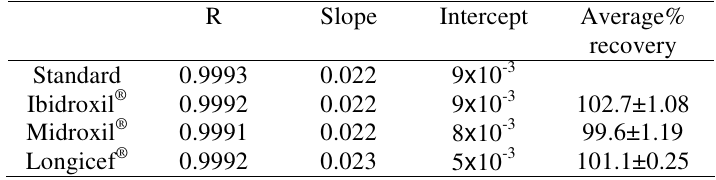
Table 4. Bulk and sample calibration graphs results